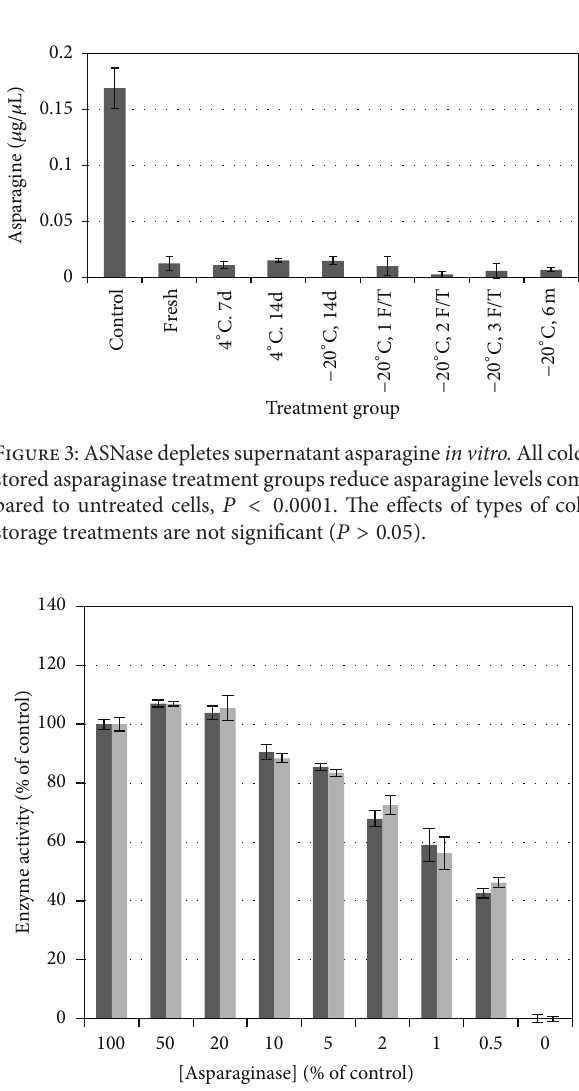
Figure 6: Effect of refrigeration on asparaginase enzyme activity. There is no significant difference in asparaginase activity between refrigeration and freshly reconstituted drug or with duration of refrigeration, 𝑃 > 0.05 . As expected, asparaginase concentration has a significant effect on enzyme activity ( 𝑃 < 0.0001 ), but no differ- ence between cold storage types at any concentration tested. This verifiesthatrefrigerateddrugretainsenzymeactivityat7and14days similar to freshly prepared